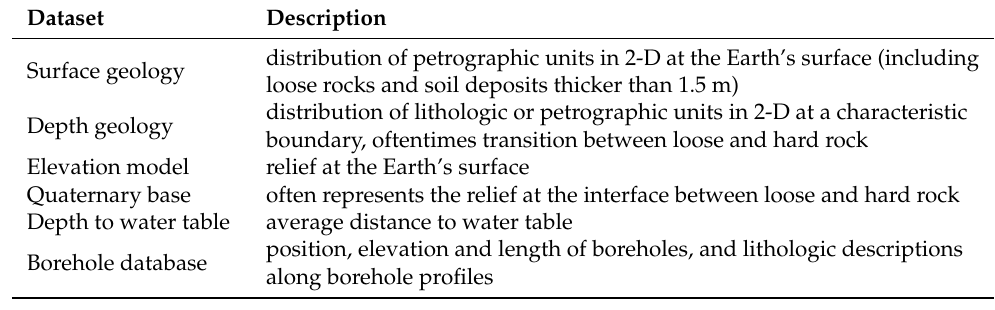
Table 1. Overview of input data.